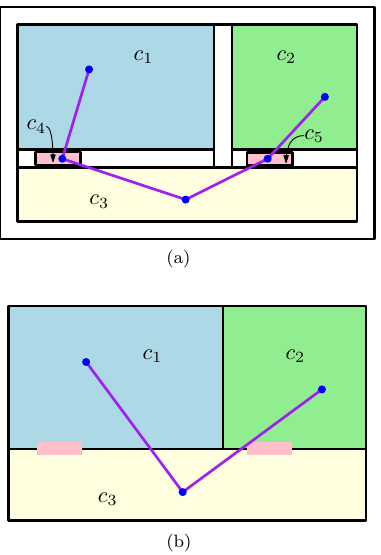
Figure 2. Two ways to model cells in an IndoorGML model. (a) 5 cells are present since doors (pink cells) are explicitly modelled. (b) The doors are not cells, their presence can be inferred by the fact that the navigation graph has an edge between 2 cells.